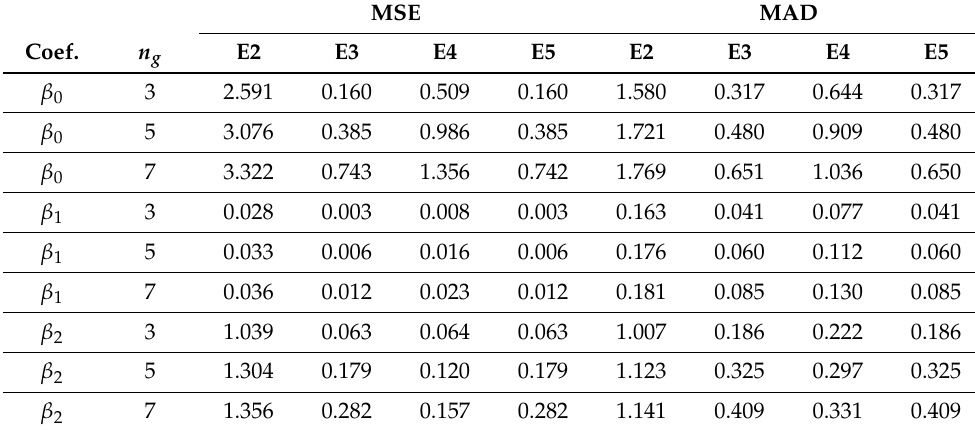
Table 4. MSE and MAD of Estimators E2 to E5 based on Aggregate-Level Y and Individual-Level X . n g is the group size in the